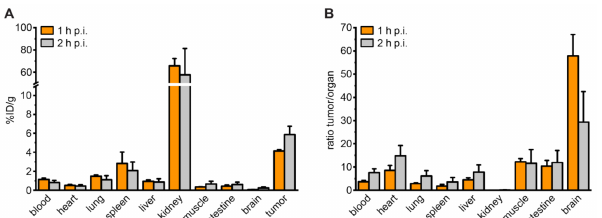
Figure 4. Organ distribution of 68 Ga-labeled PSMA-927. ( A ) Organ distribution of 60 pmol 68 Ga- labeled compound at 1 and 2 h p.i. and ( B ) corresponding LNCaP-tumor-to-organ ratios of 60 pmol 68 Ga-labeled compound at 1 and 2 h p.i. in LNCaP-tumor bearing BALB/c nu/nu mice. Data are expressed as mean % ID/g tissue ± SD ( n =